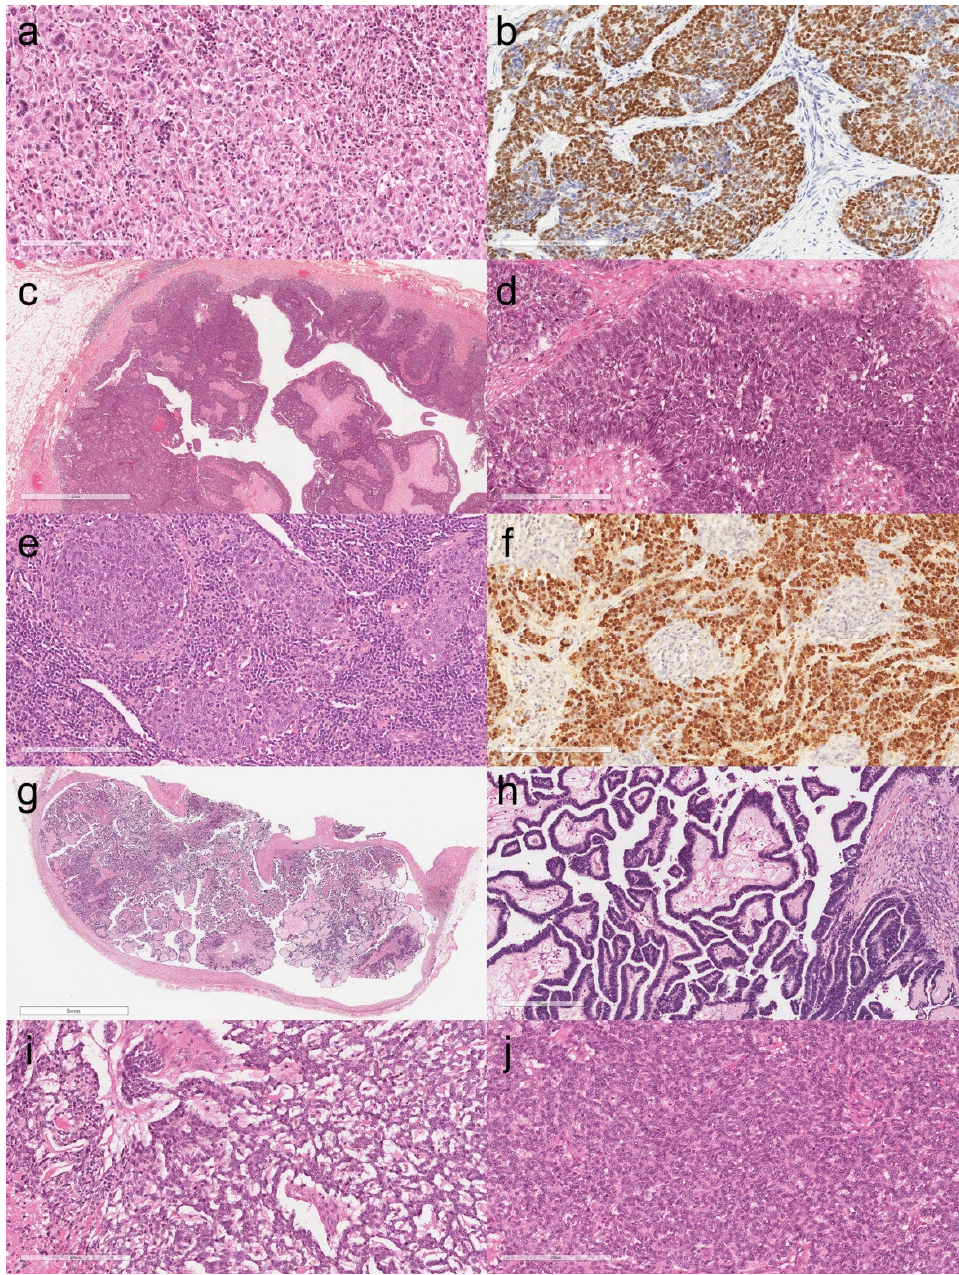
Figure 3. Non-keratinizing squamous cell carcinoma of the thymus ( a , hematoxylin and eosin, original magnification ×200). The neoplastic nuclei were strongly positive for p40 ( b , immunoperoxidase staining, original magnification ×200). Basaloid carcinoma in the context of multiloculated cyst ( c , hematoxylin and eosin, original magnification ×20). The peripheral palisading is appreciable at higher magnification ( d , hematoxylin and eosin, original magnification ×200). Lymphoepithelial carcinoma of the thymus. A dense lymphocytic infiltrate accompanies the nests of carcinoma cells ( e , hematoxylin and eosin, original magnification ×200). EBER in situ hybridization positive in the neoplastic nuclei ( f , original magnification ×200). Panoramic view of low-grade papillary adenocarcinoma ( g , hematoxylin and eosin, original magnification ×10). The tumor was composed of papillary structures lined with mildly atypical cells ( h , hematoxylin and eosin, original magnification ×100). Mucoepidermoid carcinoma of the thymus ( i , hematoxylin and eosin, original magnification ×200). High-grade area of the tumor showing solid growth with focal mucus-producing cells ( j , hematoxylin and eosin, original magnification ×200).